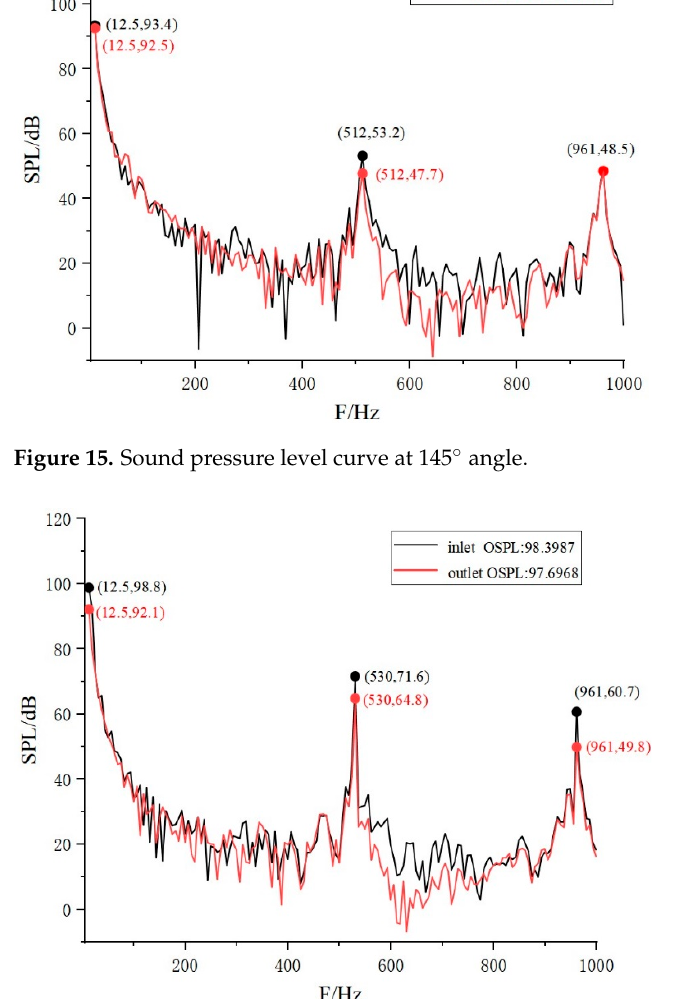
Figure 16. Sound pressure level curve at 160° angle.